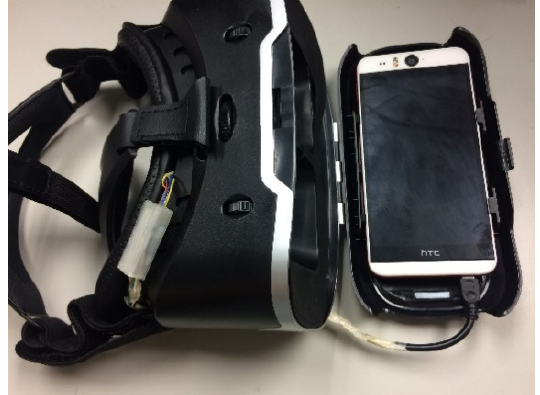
Figure 7. Mobile in the head-mounted device.